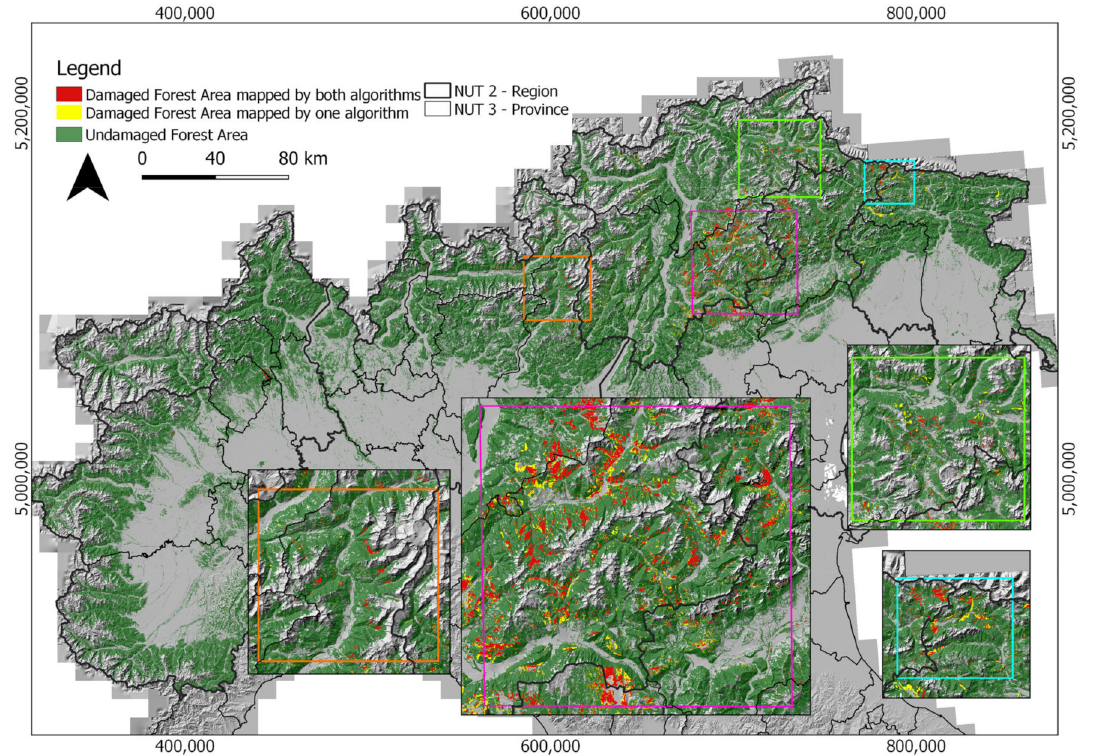
Figure 5. Damaged forest map obtained by BEAST and CCDC after 8 months after the storm (June 2019). Red areas are the forest damaged areas mapped by both the algorithms; yellow areas are the damaged forest areas mapped by just one